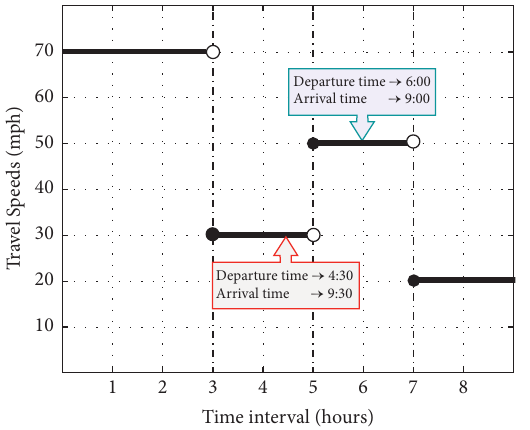
Figure 3: Travel time function corresponds to travel speed function in Figure 2.